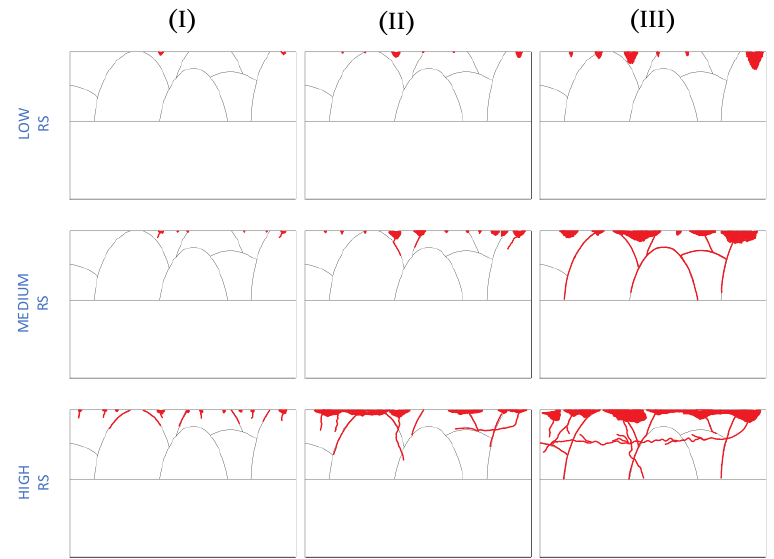
Figure 14. Schematic illustration of pitting and SCC initiation and propagation for specimens with different RS magnitudes showing preferential position and path for each level (I, II, III corresponding to different stages of galvanostatic observed events).